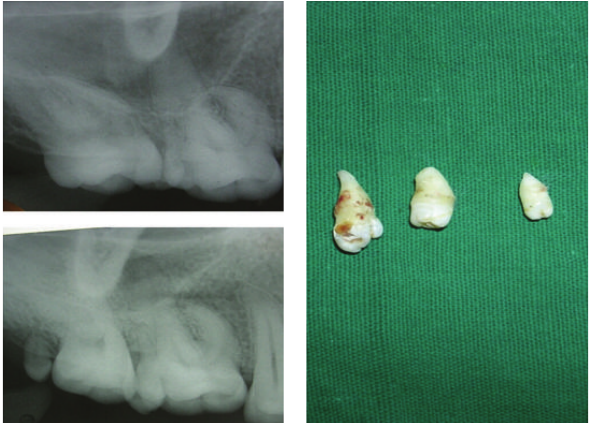
Figure 2: Showing the bilateral paramolars in occlusal and pano- ramic view in case-1.